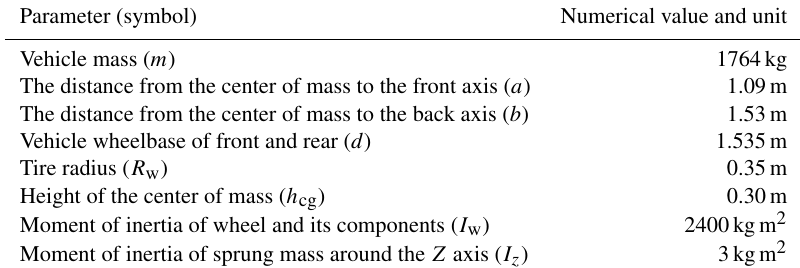
Table 1. Vehicle structure parameters.